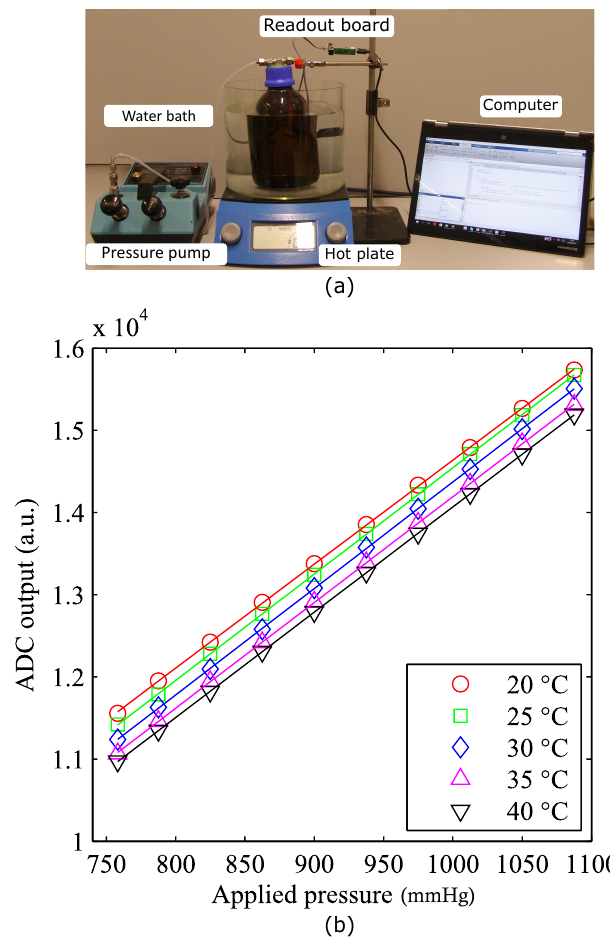
Figure 8. ( a ) Temperature sensitivity measurement setup; ( b ) plot of the measured ADC output as a function of the applied pressure for different temperature